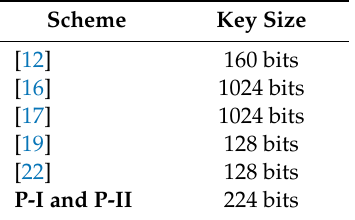
Table 5. Key sizes of the schemes.